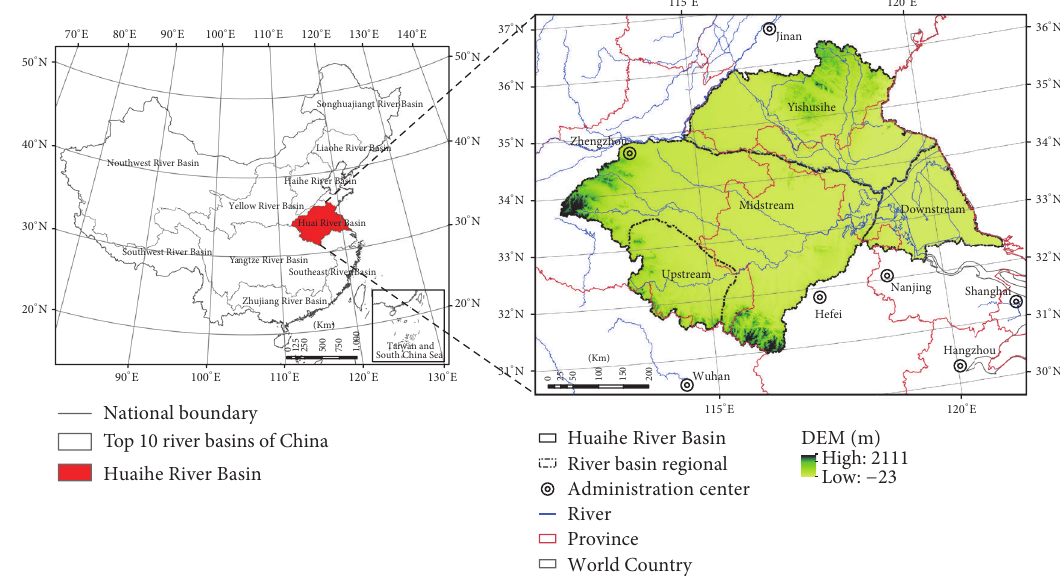
Figure 1: Location of Huai River Basin in